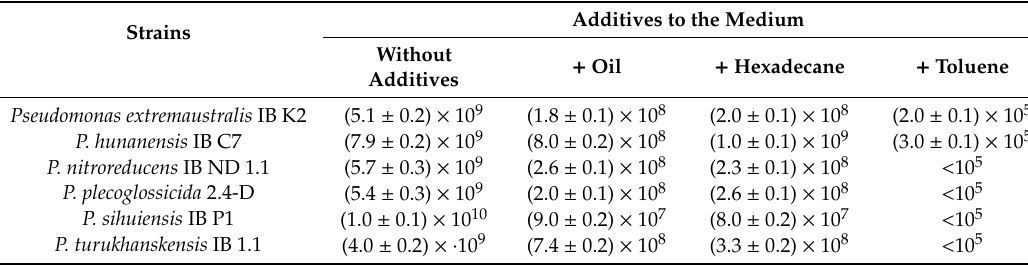
Table 4. The e ff ect of oil, hexadecane and toluene (2 g L − 1 ) on number of colonies forming units (CFU mL − 1 ) in culture media during the stationary phase of their growth on the King B